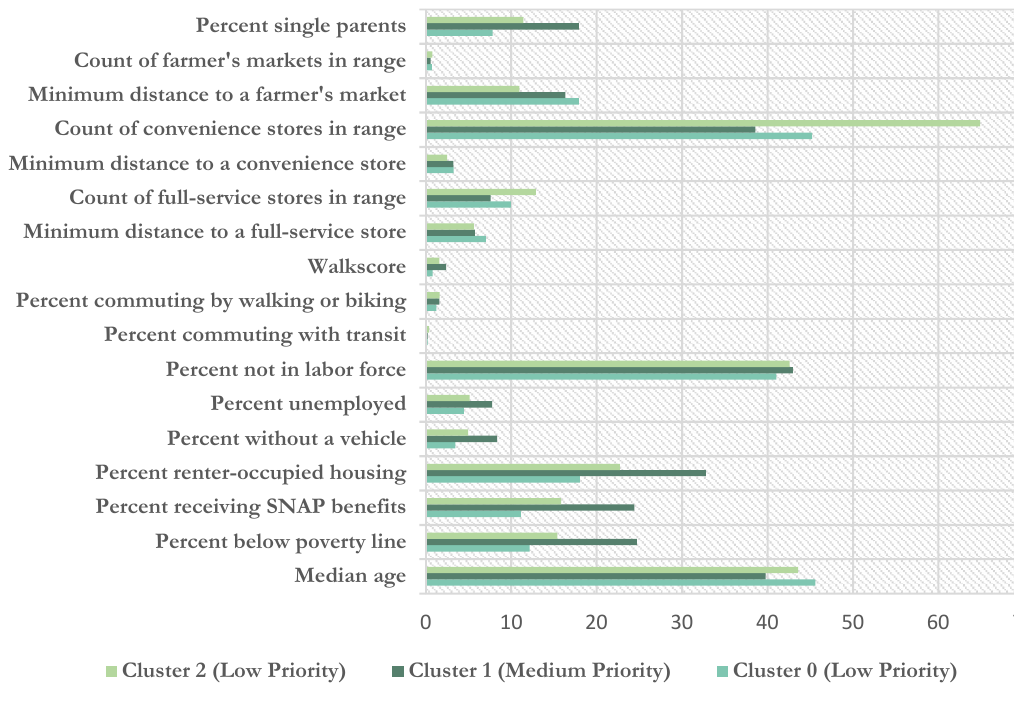
Figure 6. Average values of each variable belonging to the four urban clusters.